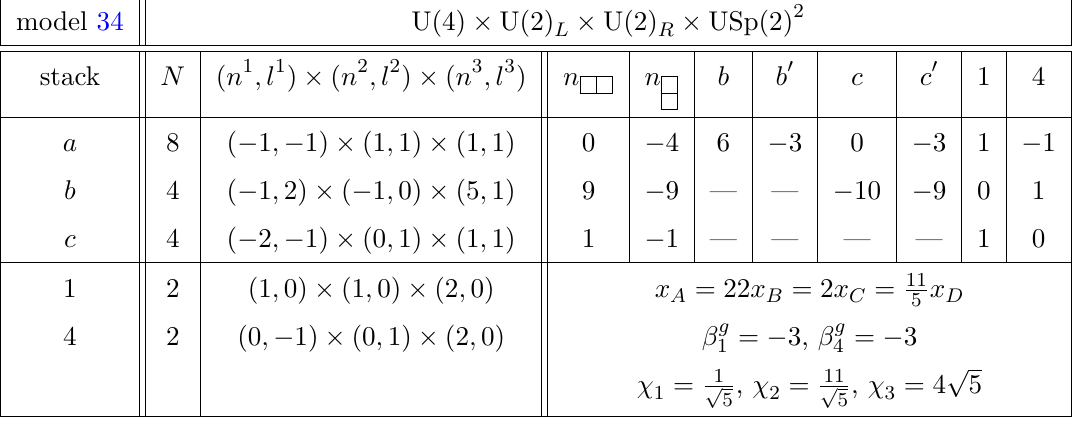
Table 34 . D6-brane configurations and intersection numbers of Model 34, and its MSSM gauge